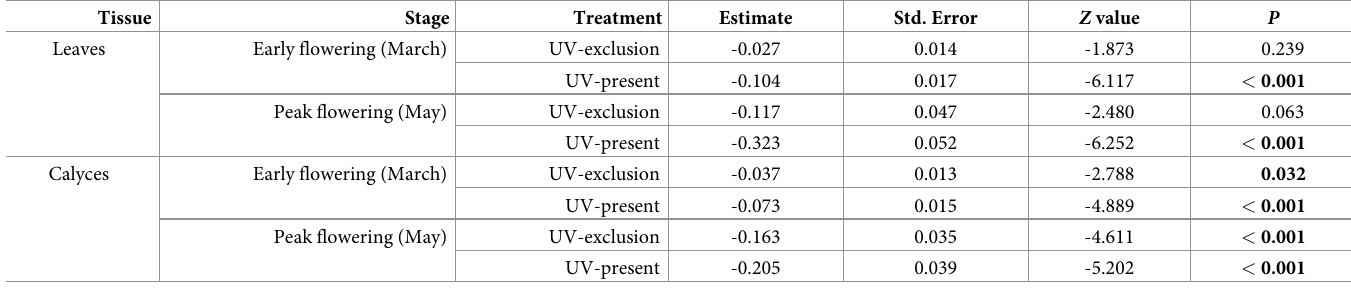
Table 3. Comparisons of the photochemical efficiency ( Fv/Fm ) between predawn and afternoon conditions. Pairwise comparisons were independently performed in leaves and calyces from the UV-exclusion and UV-present treatments and either in the early flowering (March) and peak flowering (May). Tissue Leaves